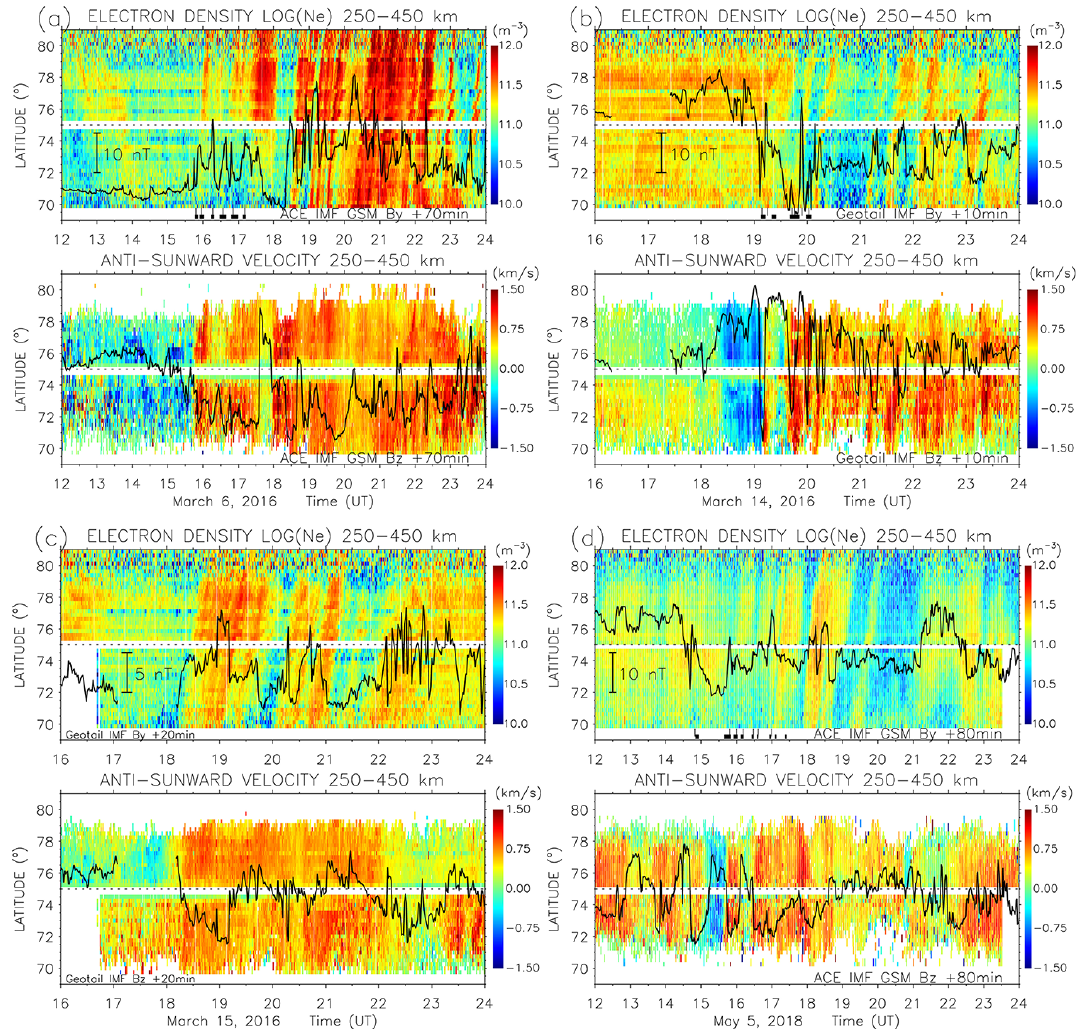
Figure 2. The RISR measurements at altitudes between 250 and 450km of electron density, N e , and anti-sunward flow velocities, V e , on (a) 6 March, (b) 14 March, (c) 15 March 2016, and (d) 5 May 2018. The time-shifted IMF B y and B z observed by ACE (GSM) and Geotail (GSE) spacecraft are